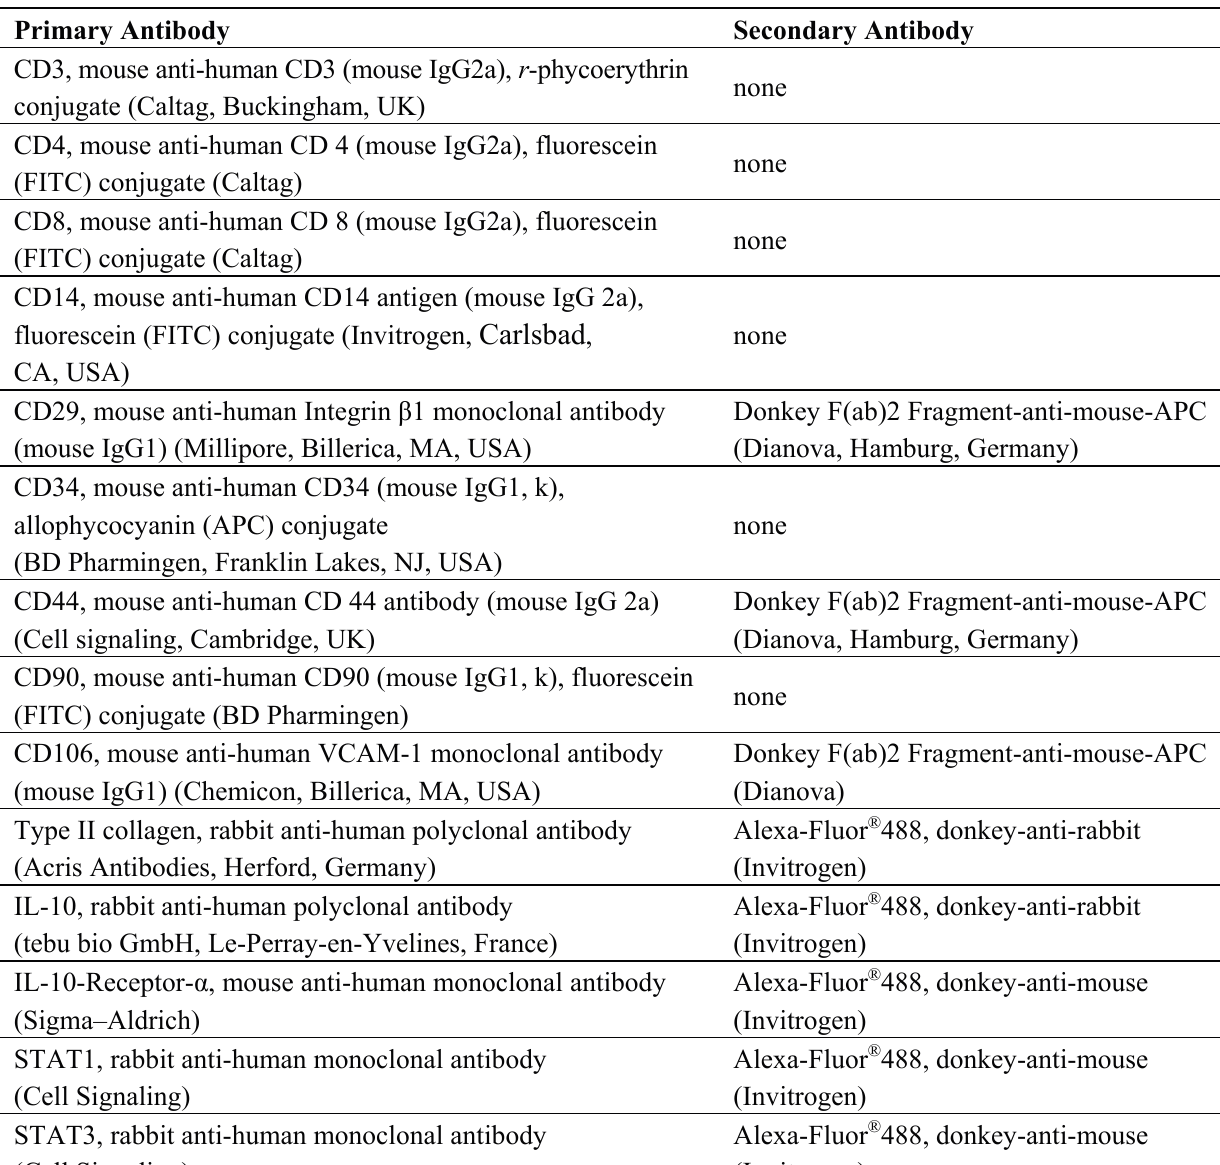
Table 2. Antibodies to surface markers used for flow cytometry and immunofluorescence labeling. Primary Antibody Secondary